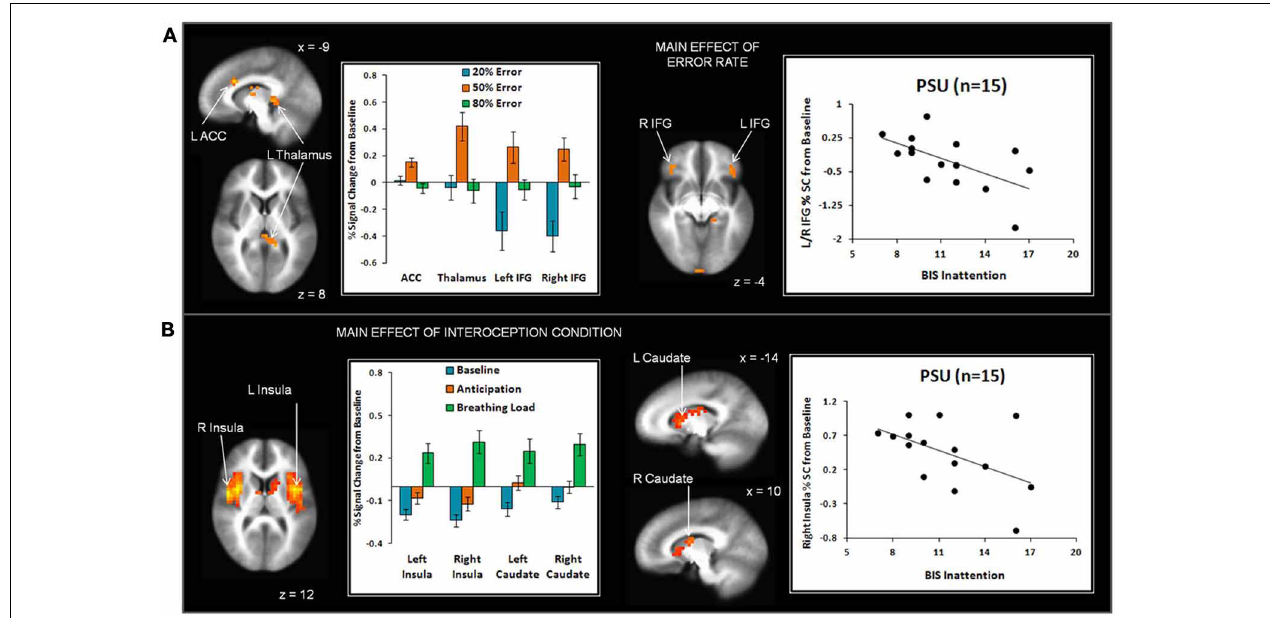
FIGURE 5 | (A) The main effect of error rate indicates that uncertainty (50% error rate) elicited greater anterior cingulate cortex (ACC), thalamus, and inferior frontal gyrus (IFG) activation than reward (20% error rate) and punishment (80% error rate). Within the problem stimulant user (PSU) group, higher Barratt Impulsivity (BIS) Inattention scores were associated with lower thalamus and IFG activation in response to 20% error rate. (B) The main